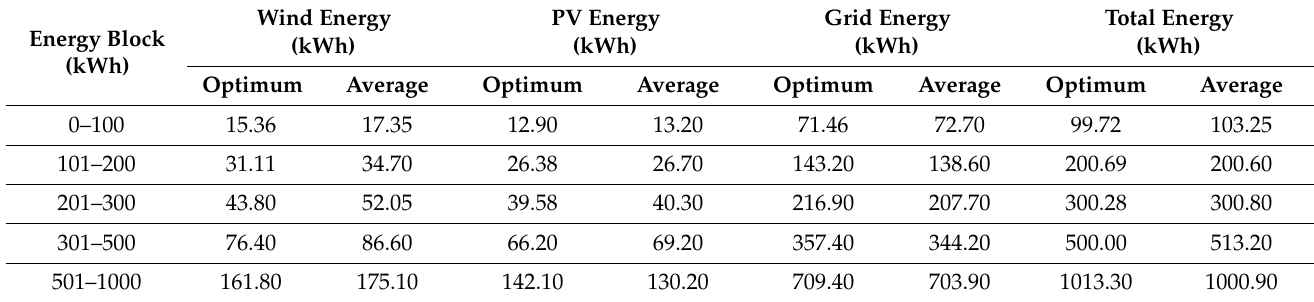
Table 6. Energy generation and tariff-based energy rates for domestic consumers.